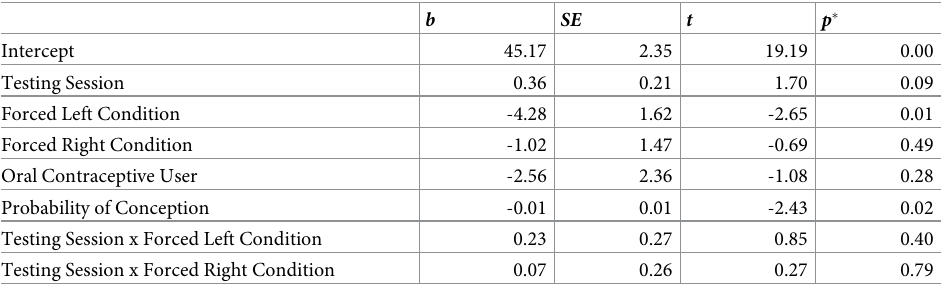
Table 4. Parameter estimates from the mixed-effects model for right ear